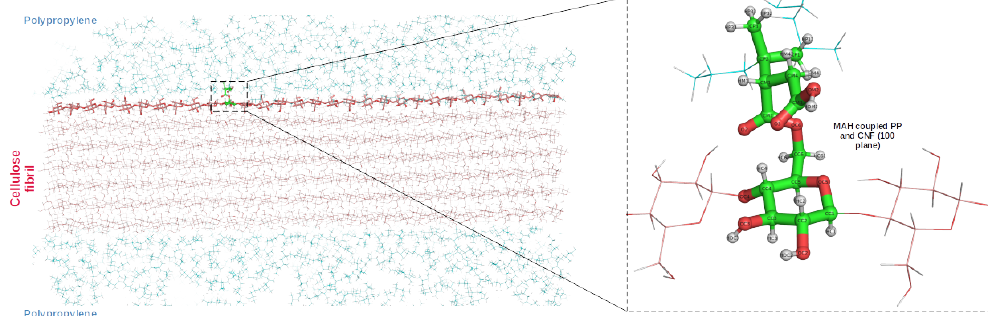
Figure 9. Left : A cross-section of the CNF30-PP50-1MAH bionanocomposite. The dashed box highlights the point of covalent linking. Right : zoomed-in view of the linking residue formed by the coupling of the internal PP residue (IPP), MAH molecule, and a cellulose residue in the (100) plane.